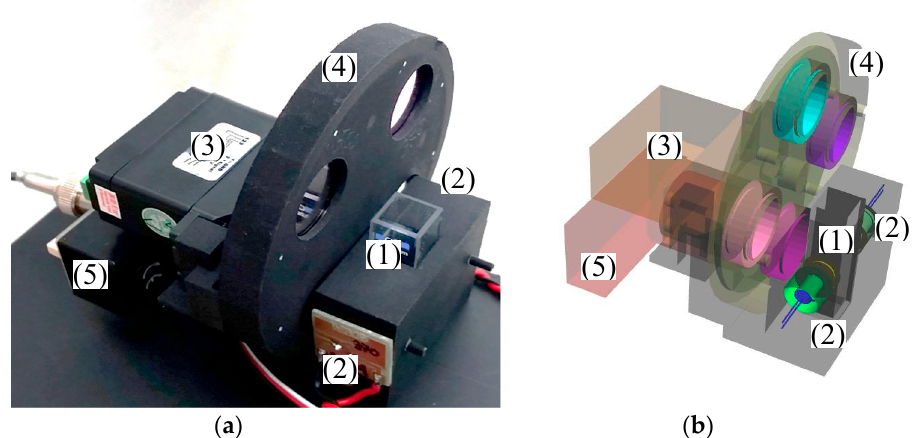
Figure 1. ( a ) 3D printed prototype of the measurement chamber with cuvette (1), LED’s (2), servo (3) for rotating the optical filter wheel (4) and the photomultiplier (5). ( b ) CAD view of the measurement